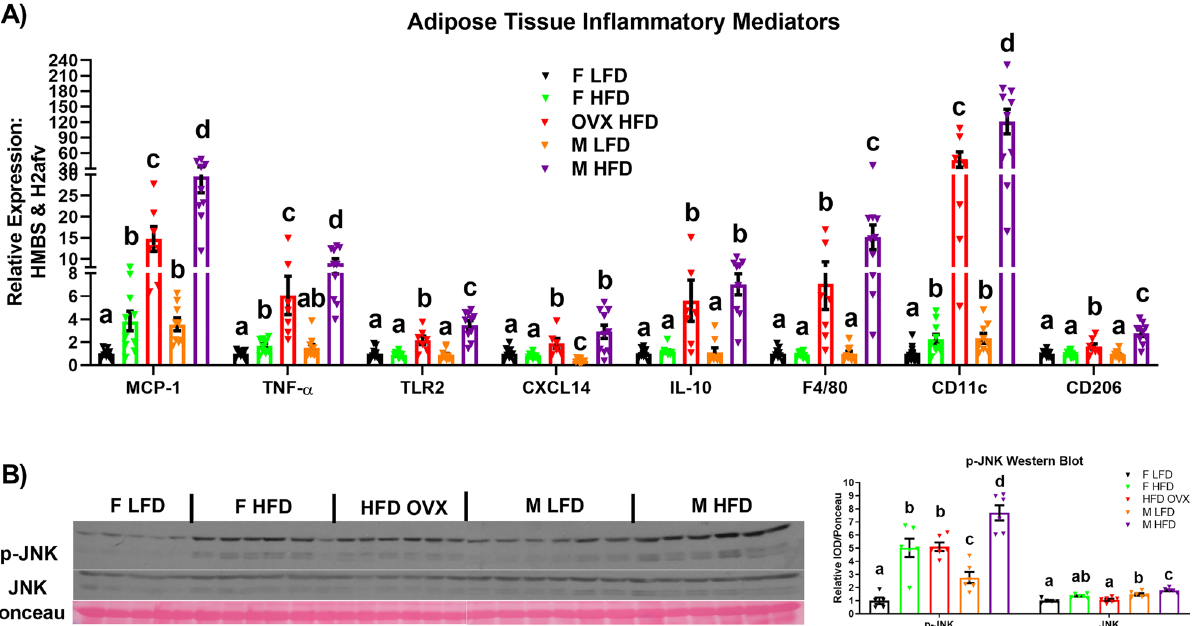
Figure 2. Despite a similar degree of adiposity, HFD estrogen-deficient females exhibit reduced adipose tissue inflammation compared to HFD males. After 16 weeks of LFD or HFD, adipose tissue inflammation was assessed via ( A ) qRT-PCR for inflammatory markers (n = 7–10), and ( B ) via western blot for JNK activation (n = 5–6). Data is presented as mean ± SE. Bar graphs not sharing a common letter are significantly different from one another (P <